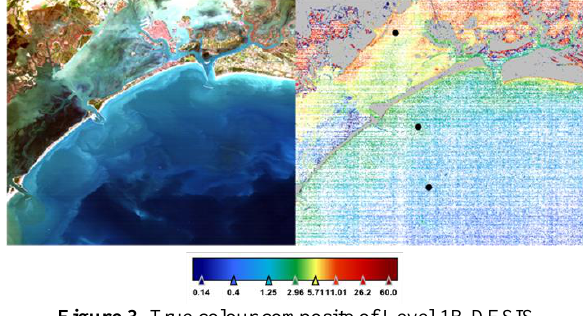
Figure 3 . True colour composite of Level 1B DESIS (04.10.2018, left) and the retrieved chlorophyll-a concentration (mg/m 3 ) with Polymer at Venice Bay. Colorbar indicates chlorophyll-a concentration in mg/m 3 and the b lack circles the position of the Rrs spectrum shown in Figure 4. Grey and white regions are masked by applying Polymer flags: optimized parameters are out of bounds, thick aerosol, cloud, land, high air mass.